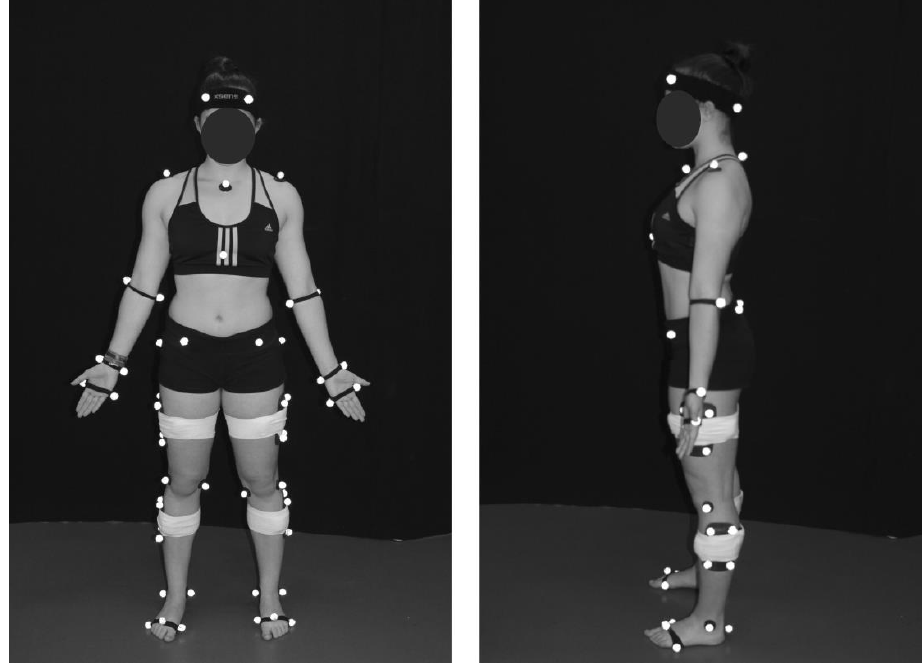
Figure 2. Reflective markers set-up for kinematical modelling. Surface electromyography (EMG) data from the rectus femoris (RF) and biceps fem- oris (BF) muscles was recorded during gait by using a Trigno Wireless system (Delsys, Boston, MA, USA) sampling at a rate of 2000 Hz. Each muscle activity was recorded by a wireless sensor containing four silver bar electrodes (size: 5 mm × 1 mm), arranged in two pairs with an inter electrode pair distance of 10 mm [23]. Electrode placement was based on the Surface Electromyography for the Non-Invasive Assessment of Muscles (SENIAM) project recommendations [24] (see Figure 3).